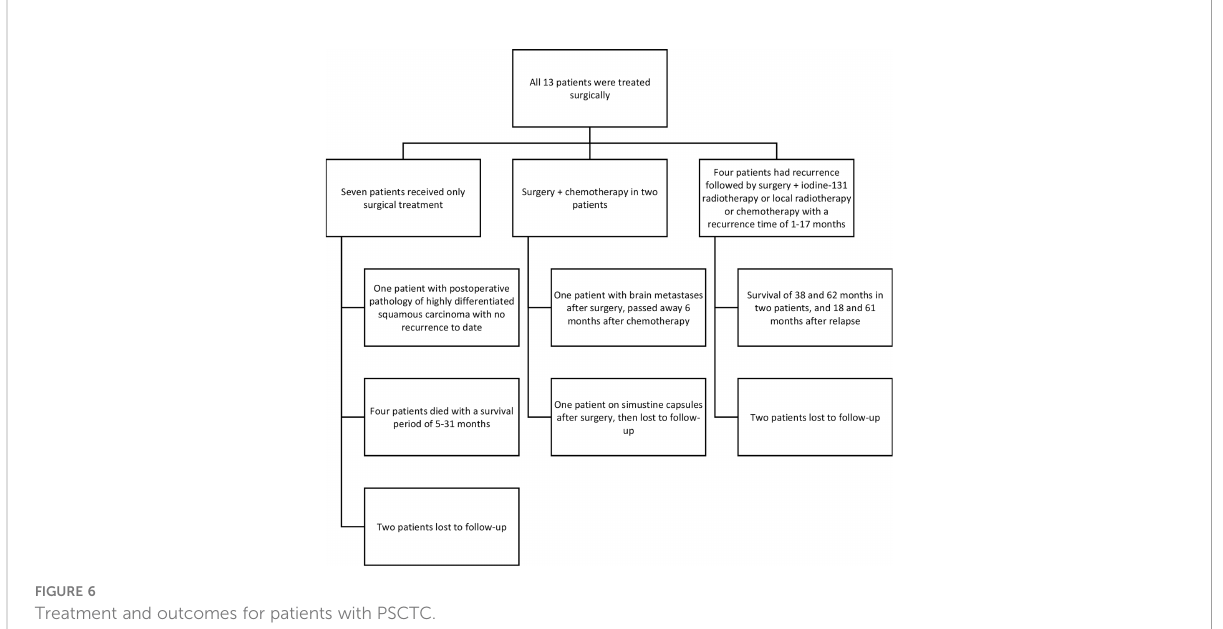
FIGURE 6 Treatment and outcomes for patients with PSCTC.